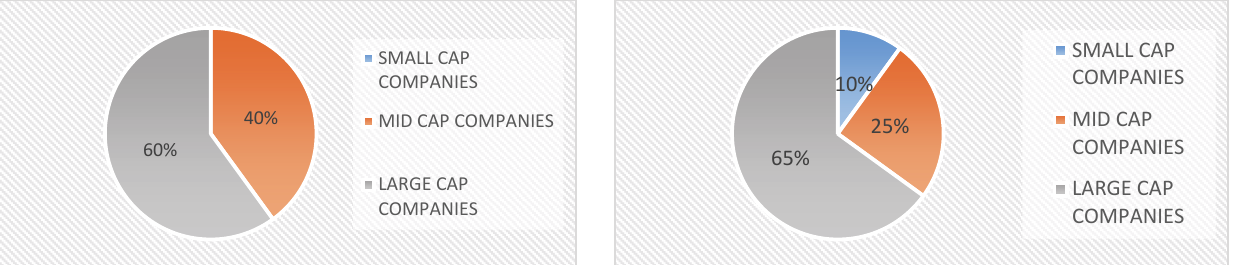
Fig. 4. Top rating portfolio constituents